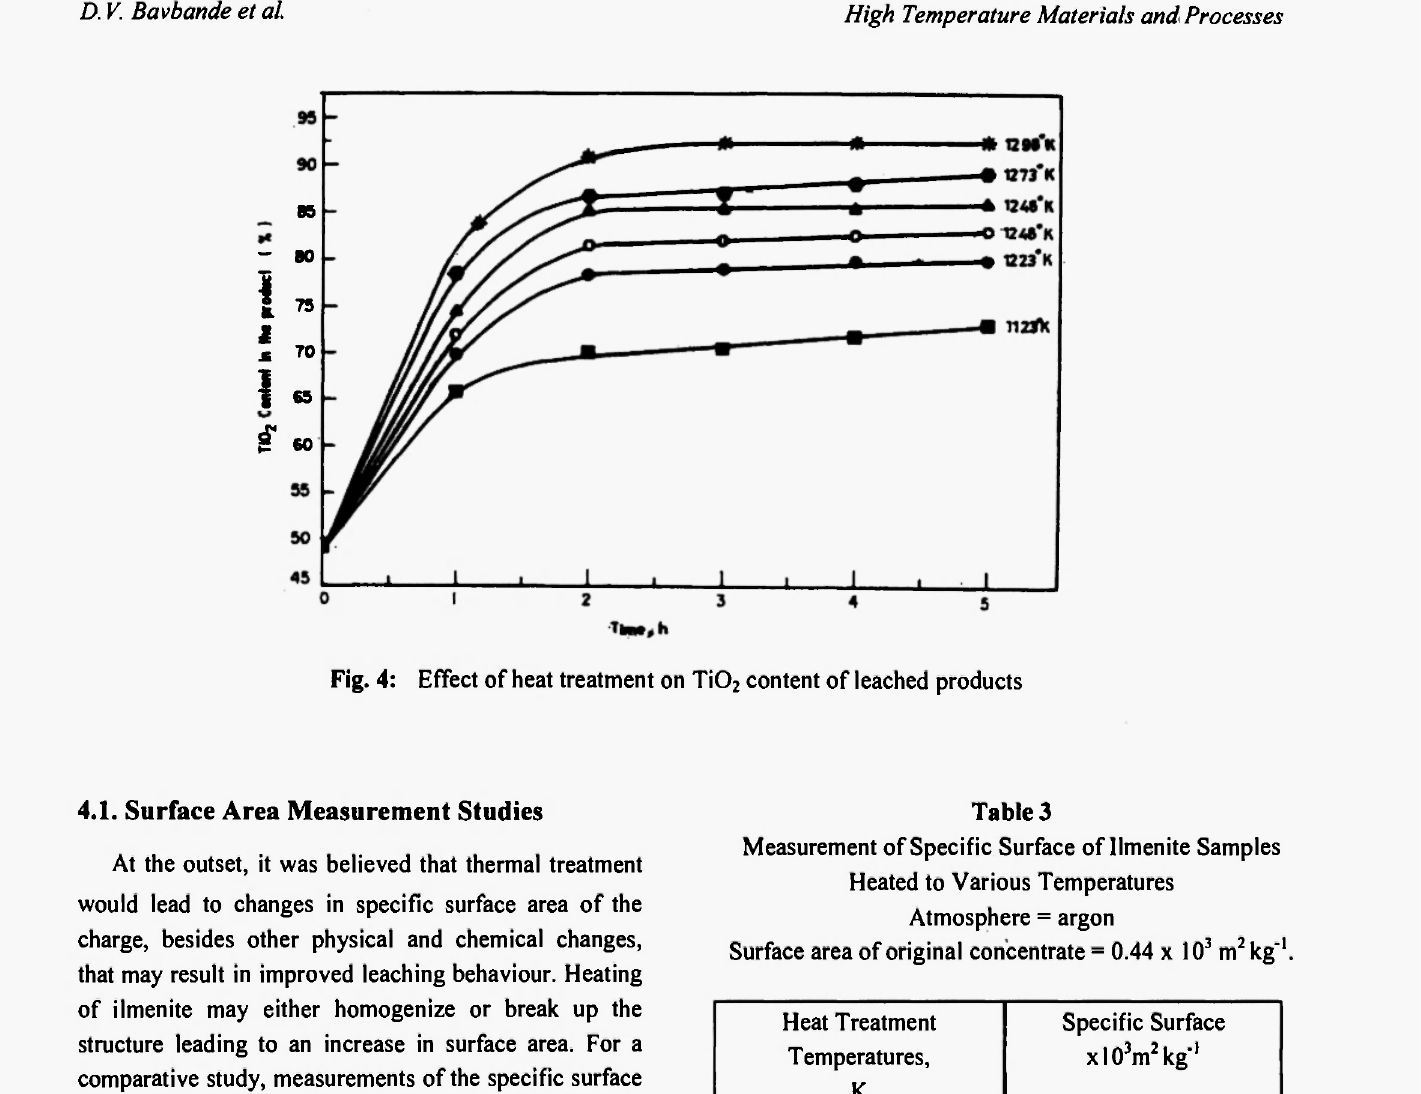
Measurement of Specific Surface of Ilmenite